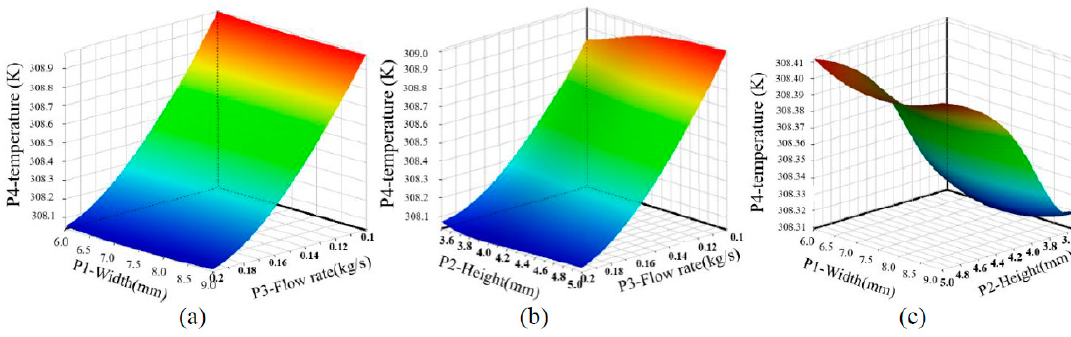
Figure 12. P1~P3 response surface diagram. ( a ) the effect of channel width P1 and cooling oil flow rate P3; ( b ) the effect of channel height P2 and cooling oil flow rate P3; ( c ) the effect of channel width